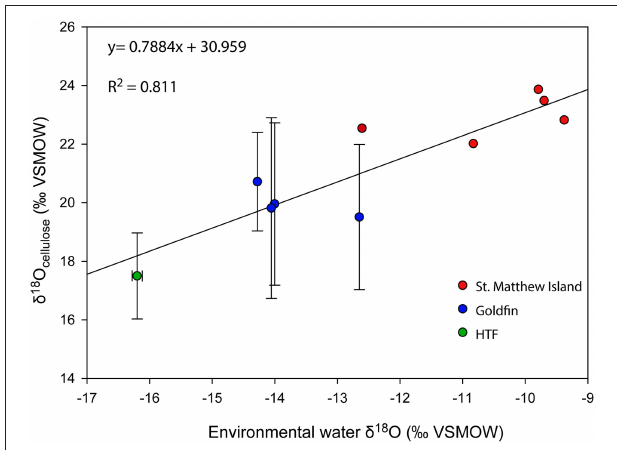
FIGURE 5 | δ 18 O relationship between environmental water and cellulose from the Kenai Peninsula samples and St. Matthew Island, Alaska. One average water δ 18 O value was used to correspond with multiple cellulose δ 18 O values (Y-axis errors). X-axis error bars for HTF do not occur because water values across the site were nearly identical. Red points without errors from St. Matthew Island have only one δ 18 O cellulose value associated with one water isotopic